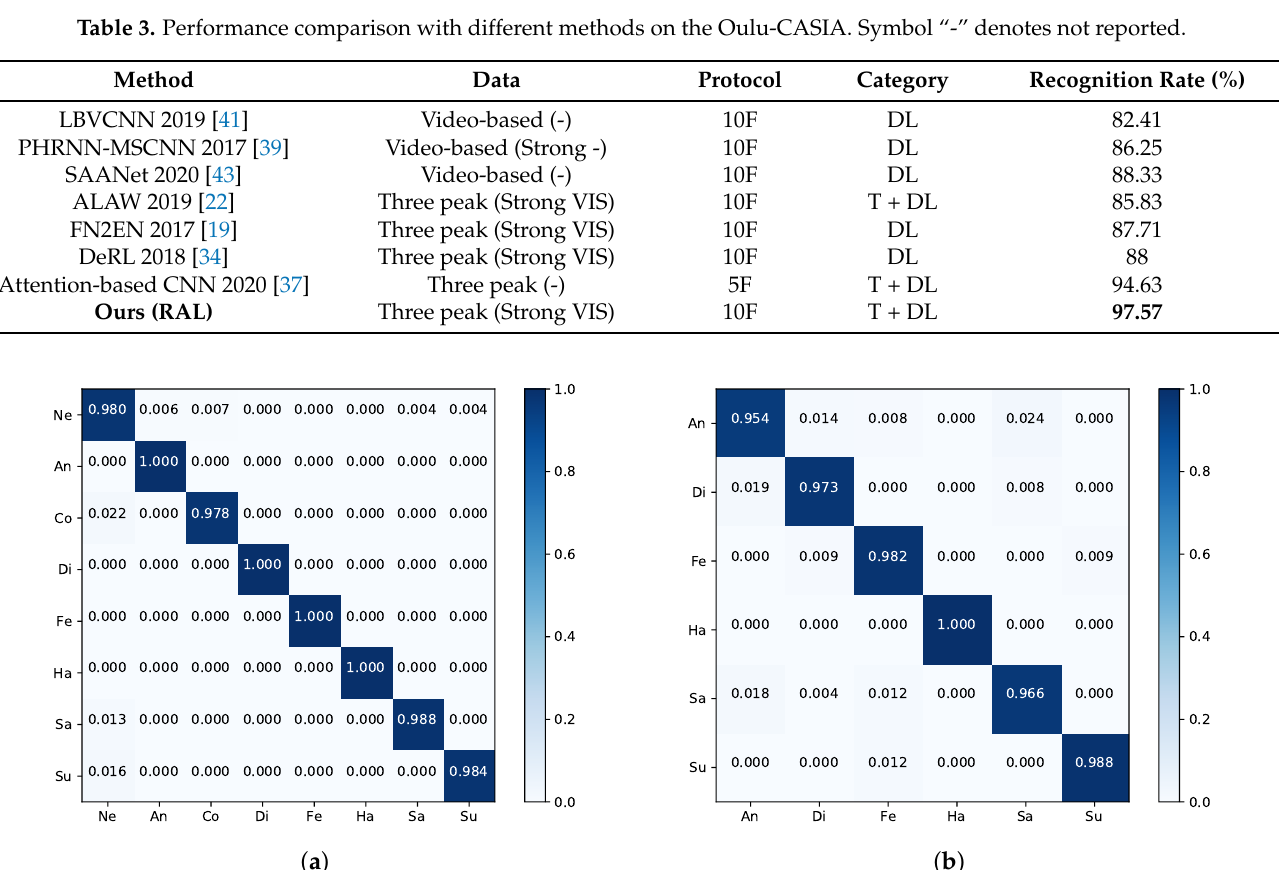
Figure 4. The confusion matrices of our PAL on the ( a ) CK+ for the eight-class and ( b ) Oulu-CASIA. The darker the color, the higher the accuracy.